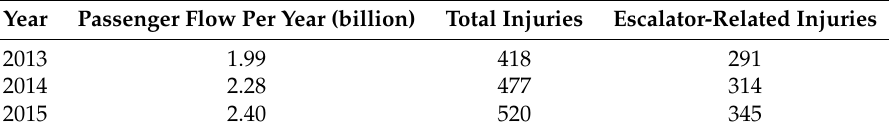
Table 1. Overview of the injuries in Guangzhou Metro [1]. Reproduced with permission from [1], Elsevier, 2019.